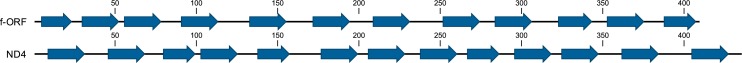
Prediction of transmembrane helices in ND4 and putative f-ORF proteins.The amino acid positions of the predicted helices is shown along each sequence.